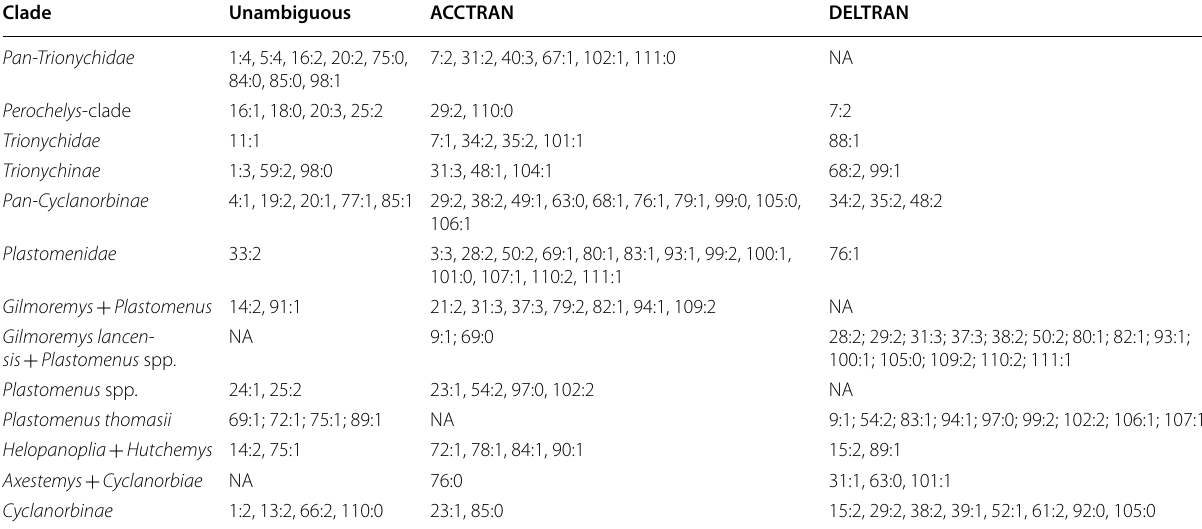
Unambiguous optimizations are those for which ACC TRA N and DELTRAN criteria agree. Numbers before the colon correspond to character numbers, and numbers after the colon correspond to character states